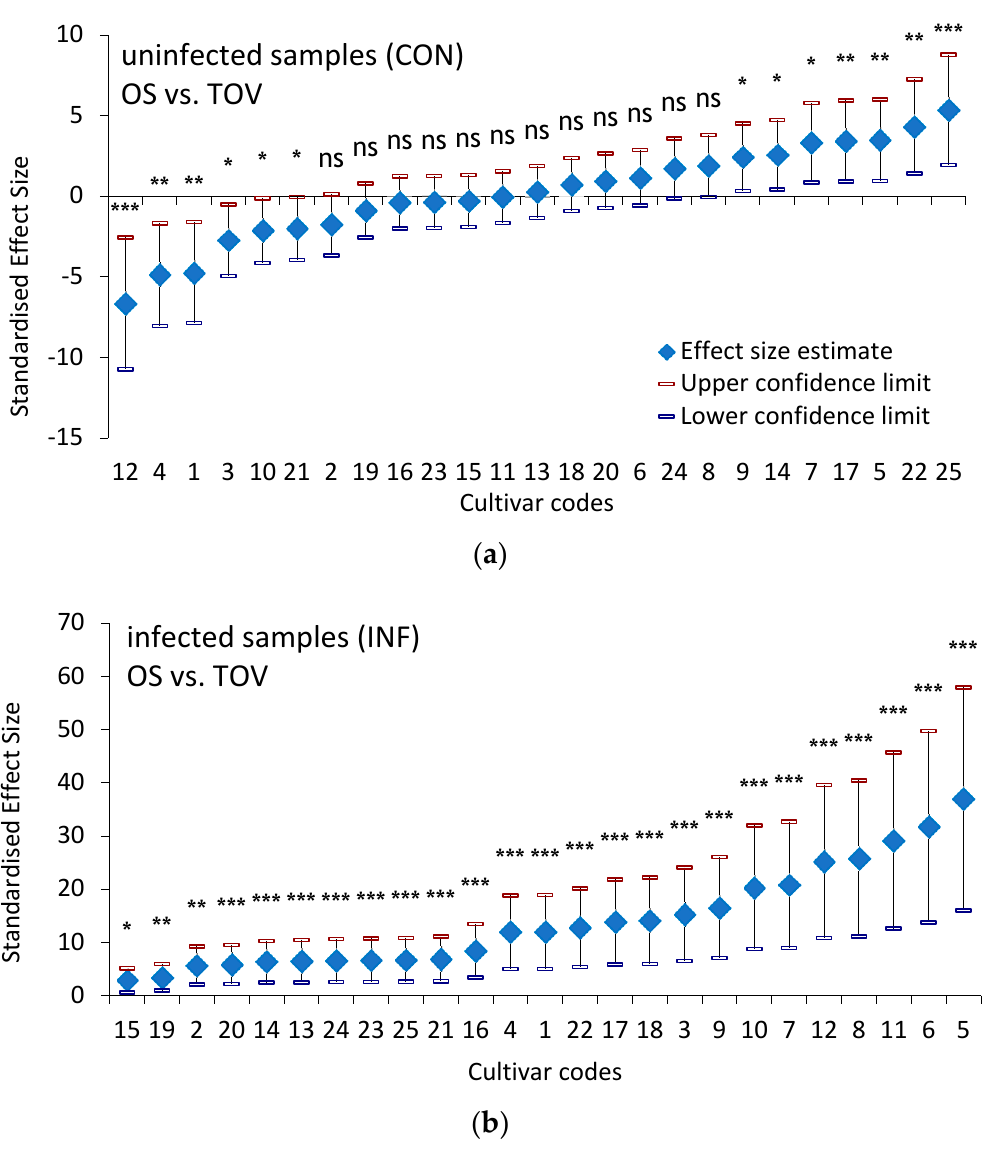
Figure 3. Estimates of the standardized effect size with a 95% confidence interval of the Fusarium infection impact on proteolytic activity (PA, μ mol TYR g − 1 flour) of 25 winter wheat cultivars grown at ( a ) OS—Osijek and ( b ) TOV—Tovarnik locations. Signification codes: 0 < *** < 0.001 < ** < 0.01 < * < 0.05, ns – non significant.